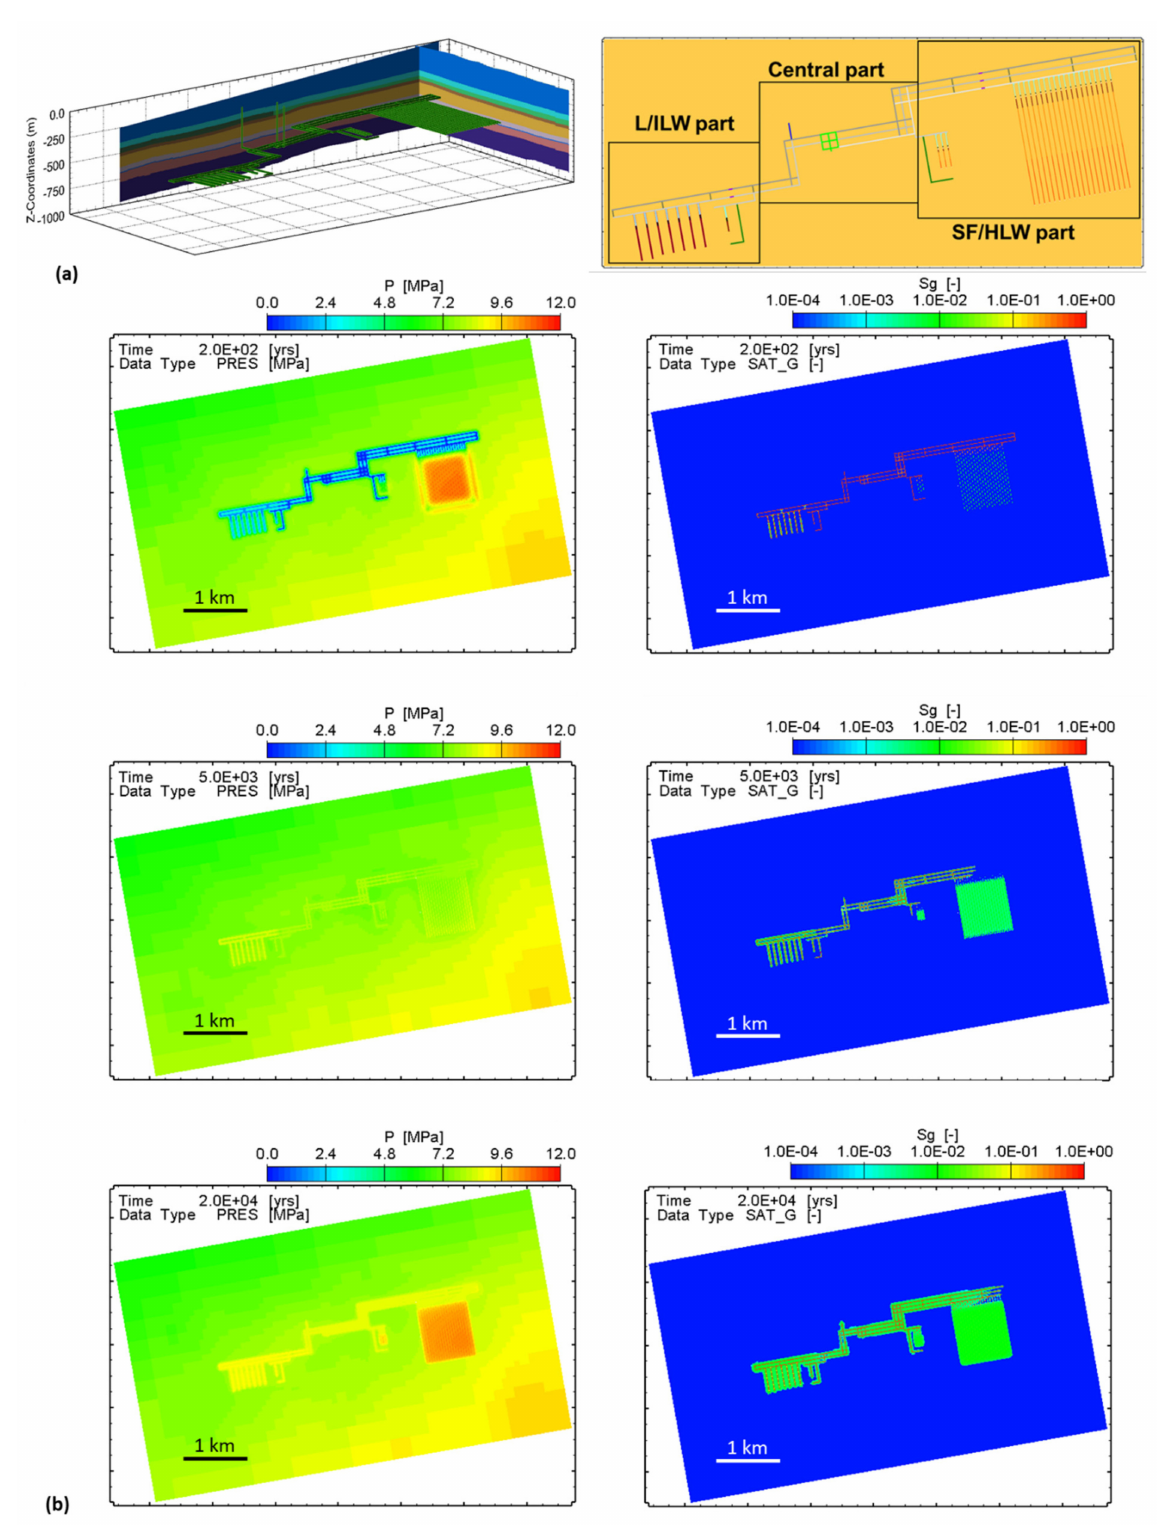
Figure 12. ( a ) Example of a site-specific repository project implemented in 3D model; ( b ) pressure ( left ) and gas saturation ( right ) simulated at the repository level with a 3D repository